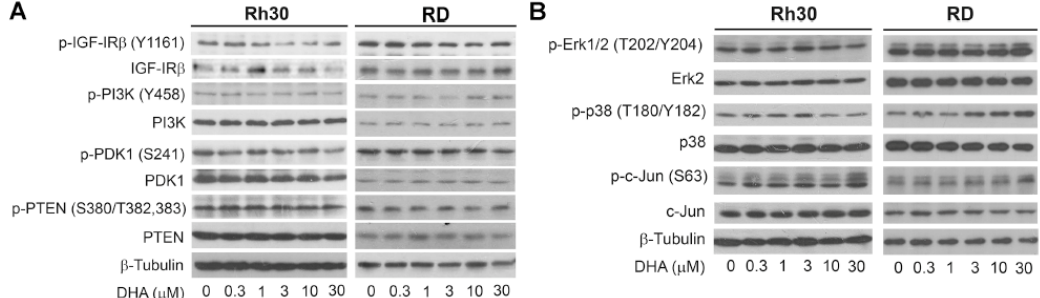
Figure 5. DHA does not alter the phosphorylation of IGF-1R/PI3K/PTEN and Erk1/2 in tumor cells. ( A , B ) Rh30 or RD cells were treated with DHA (0 − 30 μ M) for 24 h, followed by Western blotting with indicated antibodies.